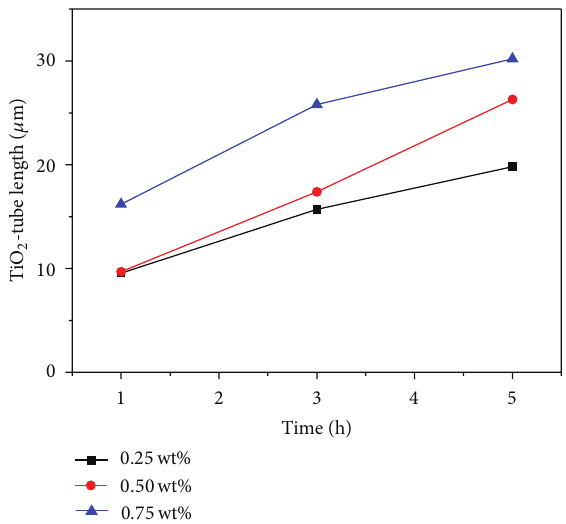
Figure 3: TNT-array length as a function of NH 4 F concentration and anodization